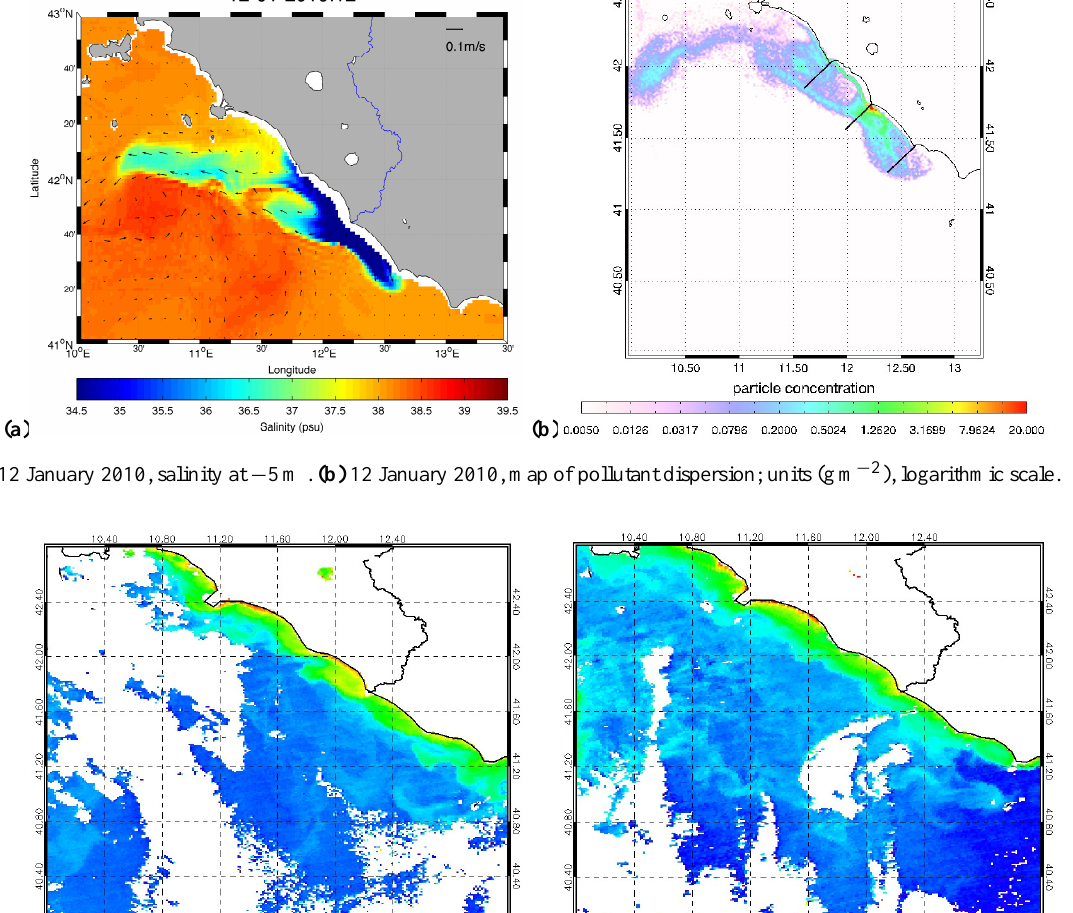
) Fig. 6. (a) 12 January 2010, map of K490; units (m − 1 ), logarithmic scale. (b) 16 January 2010, map of K490; units (m − 1 ), logarithmic 31 Fig. 6a. 12 January 2010, map of K490 ; units ( m − 1 ), logarithmic scale. Fig. 6b. 16 January 2010, map of K490; units ( m − 1 ), logarithmic scale. Fig. 5b. 12 January 2010, map of pollutant dispersion; units ( gm − 2 ), logarithmic scale. 30